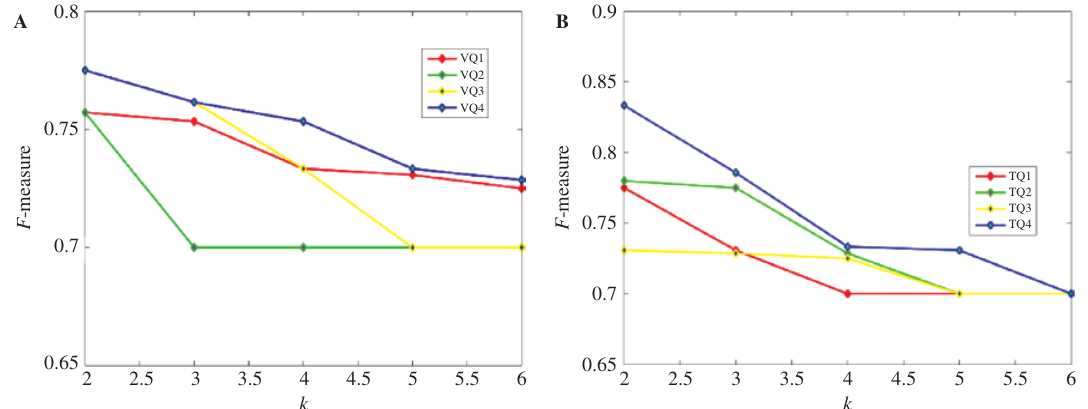
Figure 8: F -measure